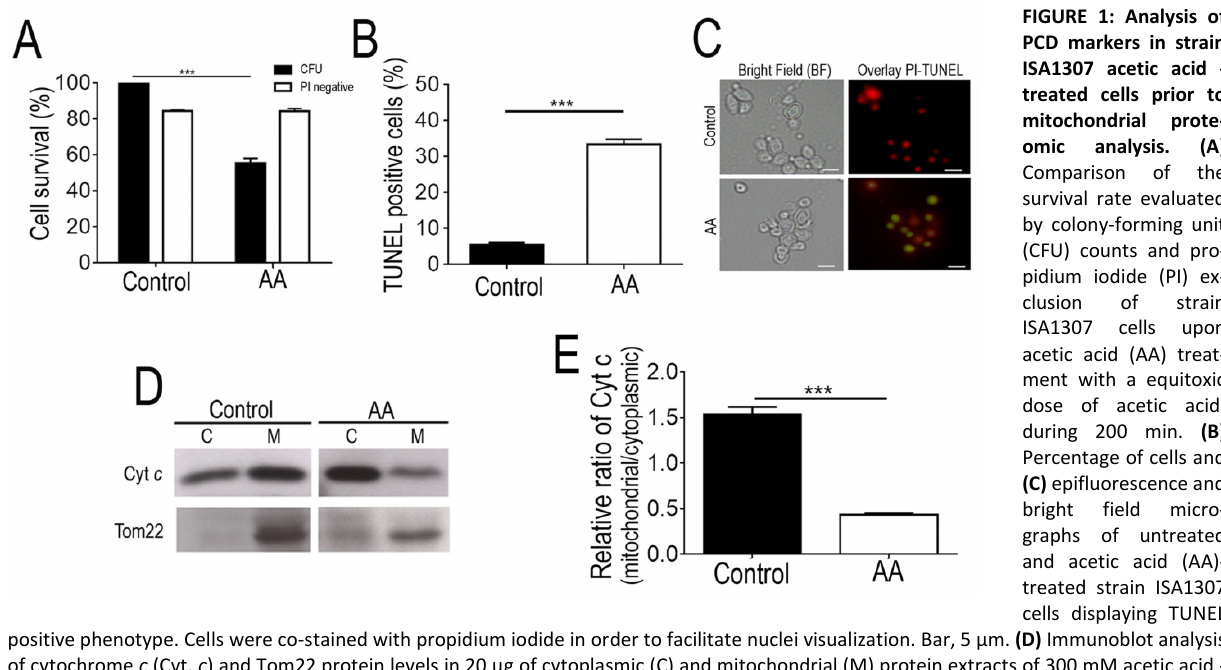
FIGURE 1: Analysis of PCD markers in strain ISA1307 acetic acid - treated cells prior to mitochondrial prote- omic analysis. (A) Comparison of the survival rate evaluated by colony-forming unit (CFU) counts and pro- pidium iodide (PI) ex- clusion